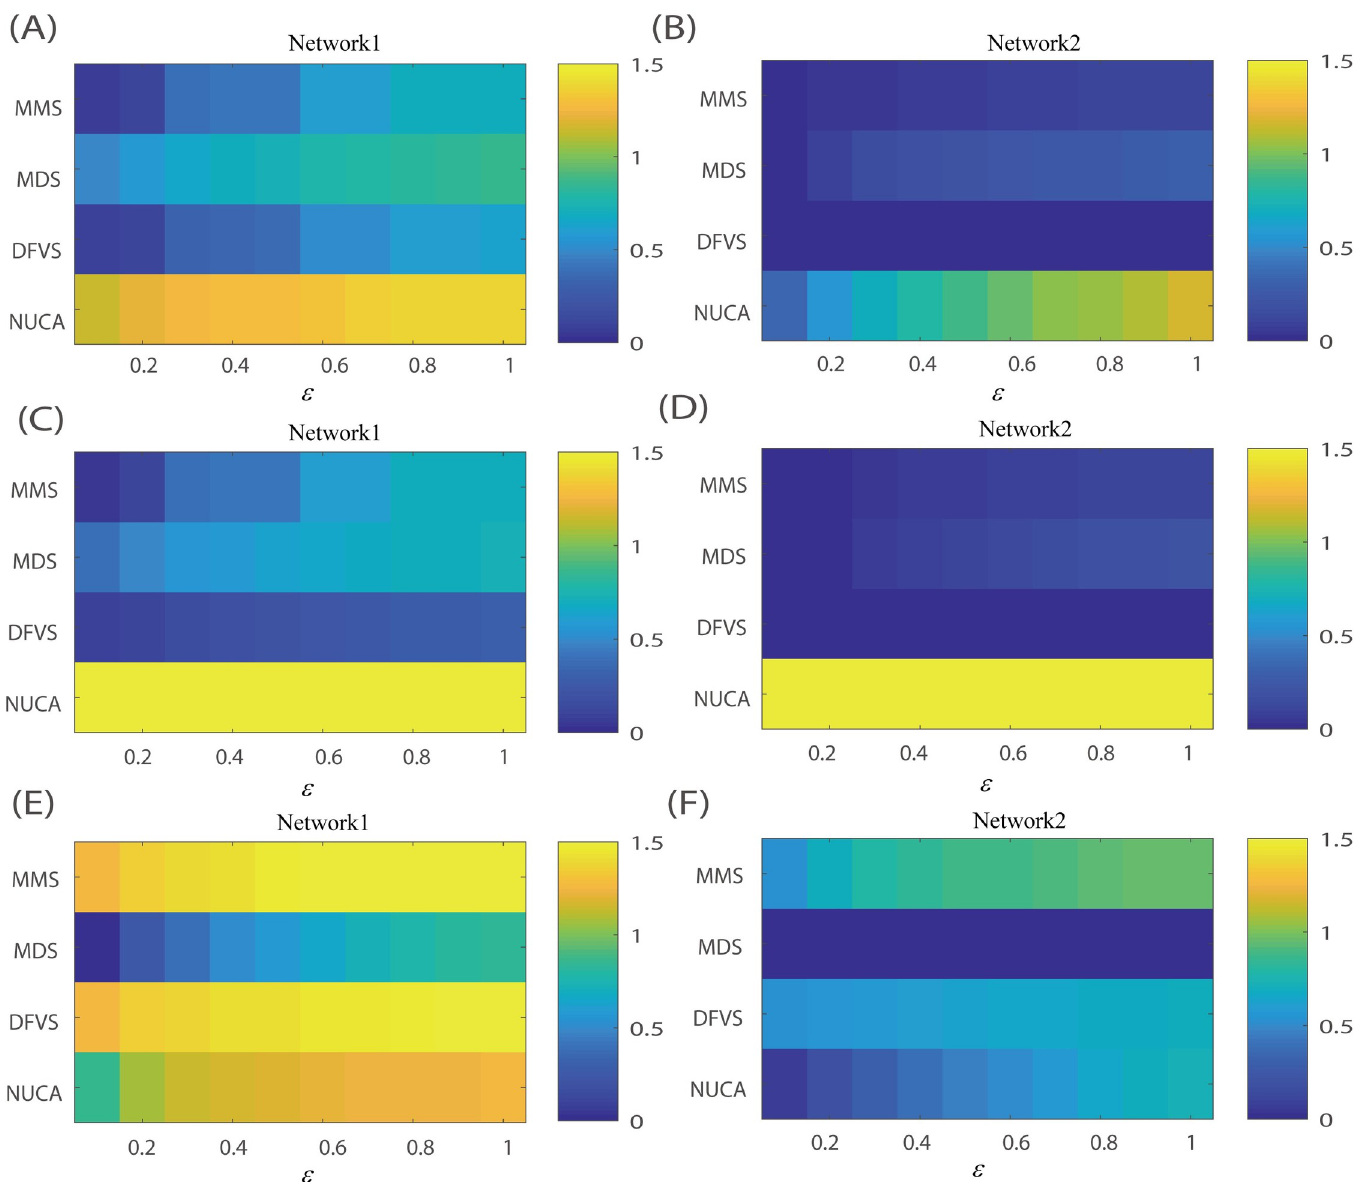
Fig 2. The evaluation of structural network control methods by simulation of biological networks. The goal is to evaluate the control efficiency by synthetically achieving control of the networked nonlinear Lorentz oscillator system towards desired attractors on two biological directed protein interaction networks from different resources (i.e. Network-1 and Network-2). (A-B) Desired attractor (8,484, 8.484, 27); (C-D) Desired attractor (-8,484, -8.484, 27); (E-F) Desired attractor (0, 0, 0). The efficiency of a given network is measured by the average value for different tolerance errors from 0.1 to